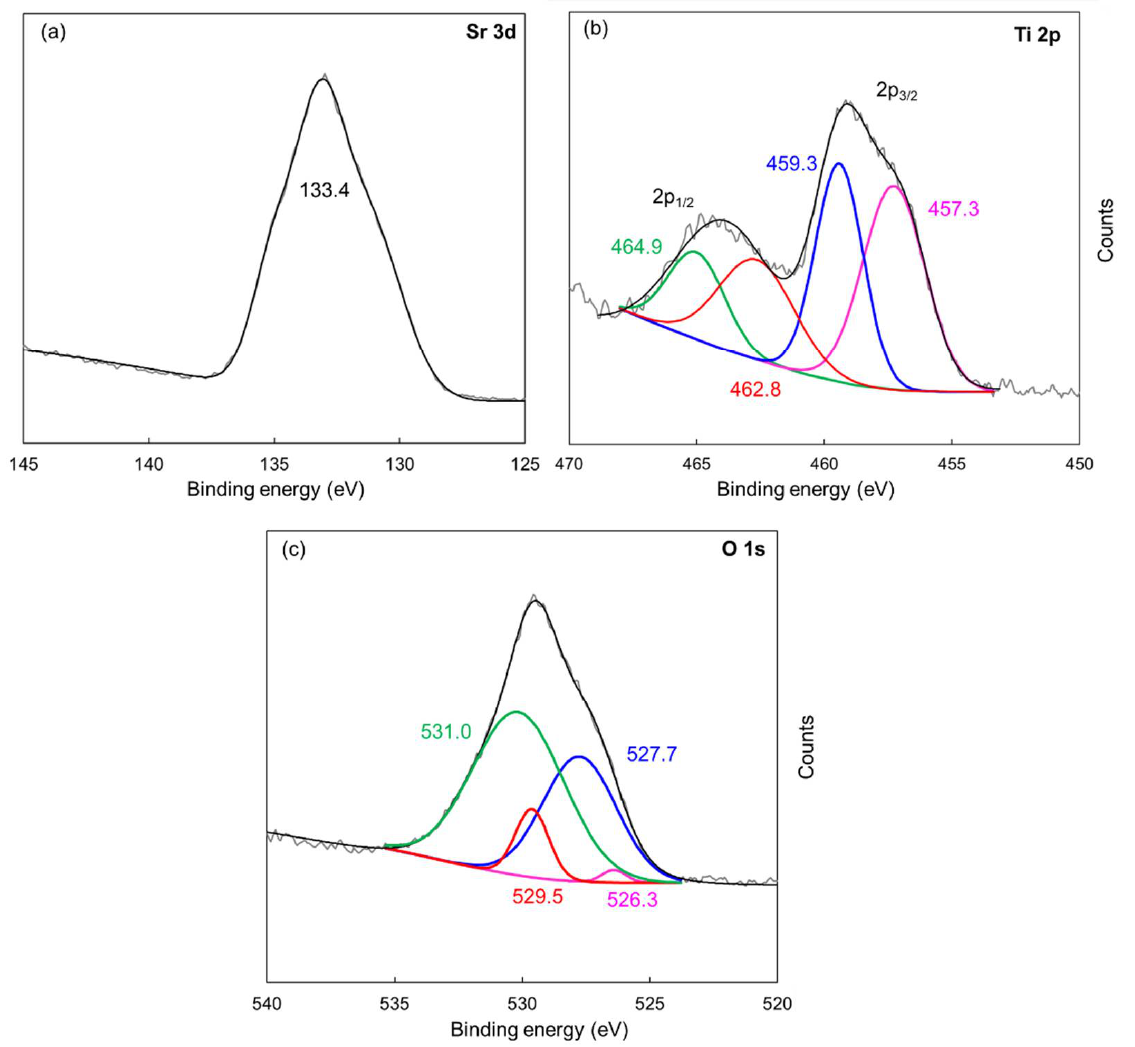
Figure 4. XPS HR spectra of Sr 3d, Ti 2p, and O 1s of STOm.